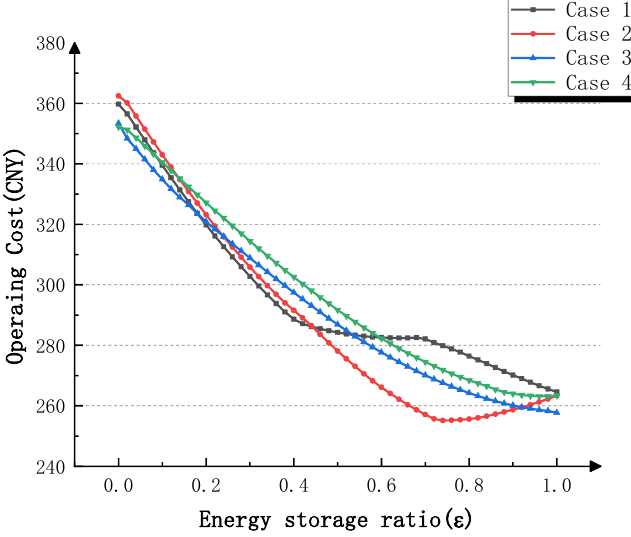
Figure 11. The influence of energy storage ratio on operating cost (CNY can be converted into USD based on CNY 1 = USD 0.1496 on 1 June 2022).